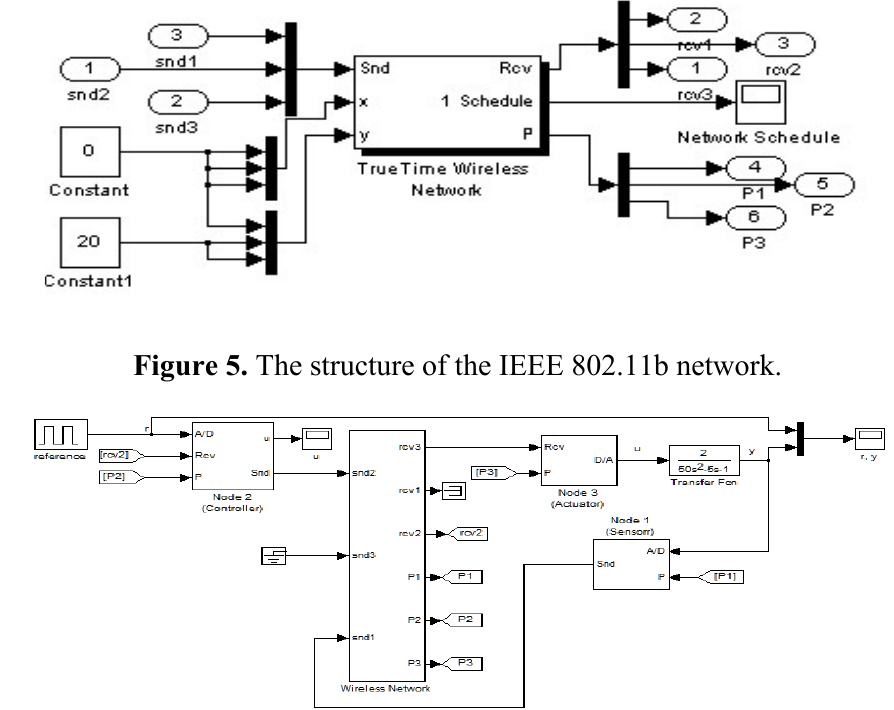
Figure 6. The structure of the networked control system (NCS) in this paper.